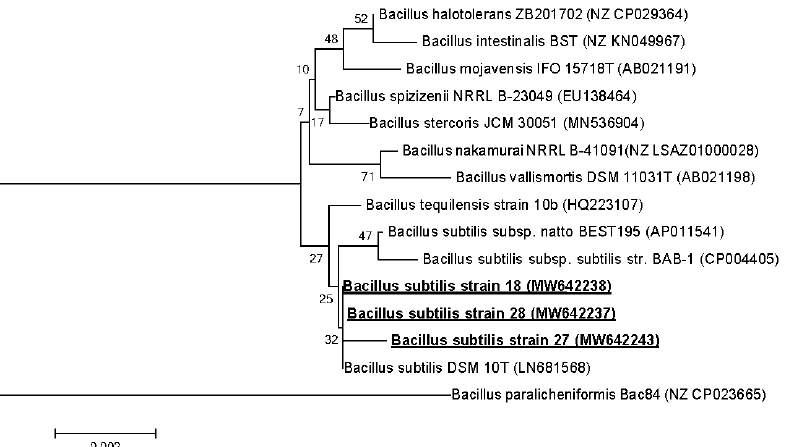
Figure 5. Phylogenetic position of strains 18, 27 and 28 based on the results of the comparative analysis of the nucleotide sequences of the 16S rRNA genes. The scale corresponds to 2 nucleotide substitutions per every 1000 nucleotides (evolutionary distance). The neighbor-joining method was used. The root was determined by including the sequence of Bacillus paralicheniformis Bac84 (NZ CP023665) as an external group.